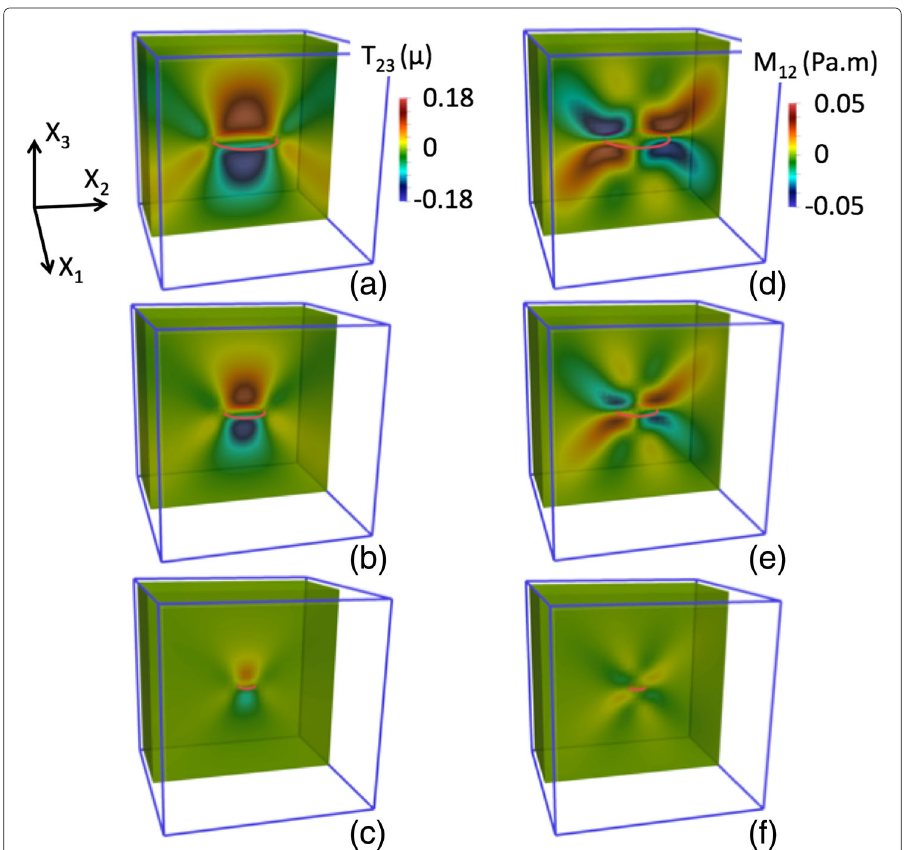
Fig. 2 Self-annihilation of a disclination loop. The disclination loop (red line) is let to self-relax under its own elastic field. ( a , b , c ) Relaxation of the internal shear stress field. ( d , e , f ) Relaxation of the internal couple-stress